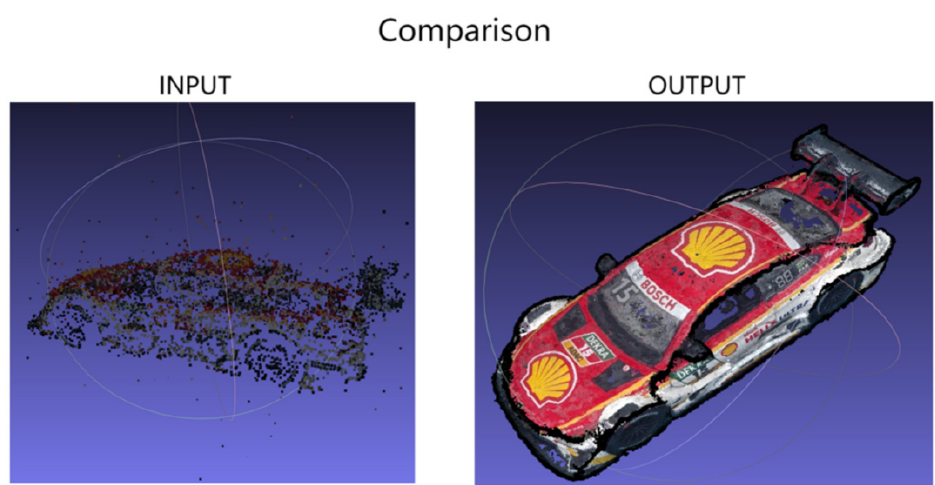
Figure 13. The comparison between the sparse and dense point